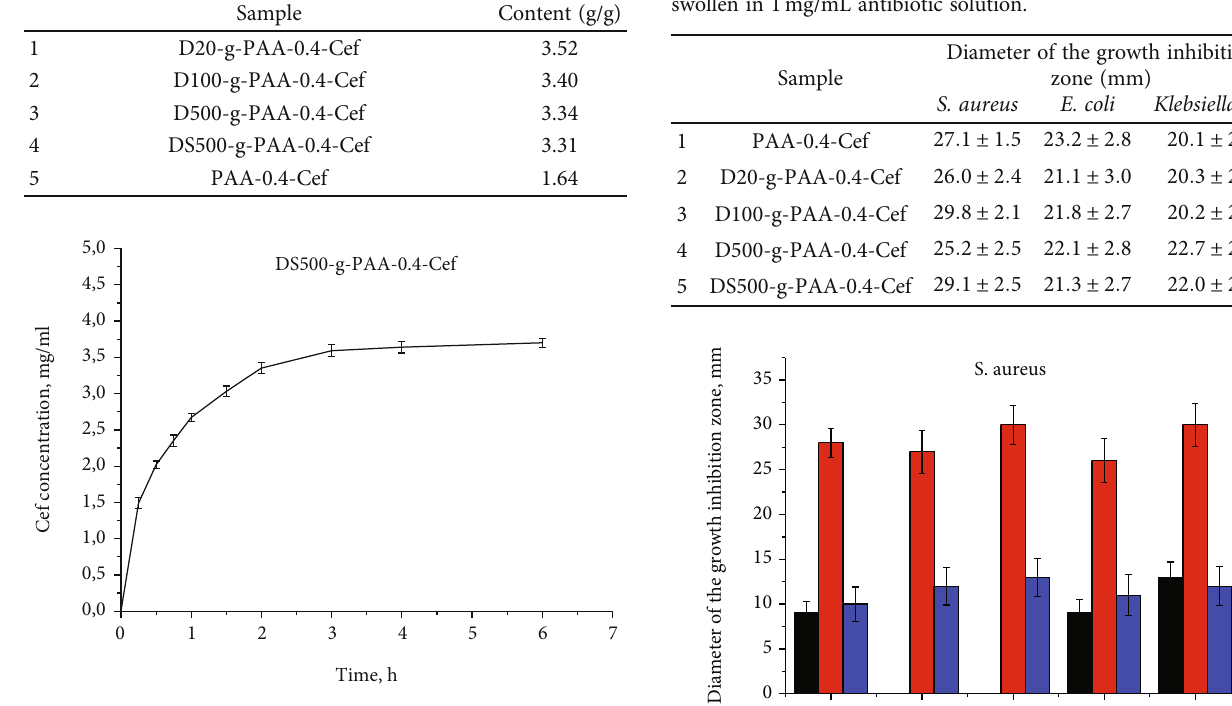
Figure 3: Cefuroxime concentration in water solution vs. time of contact with DS500-g-PAA-0.4-Cef hydrogel.